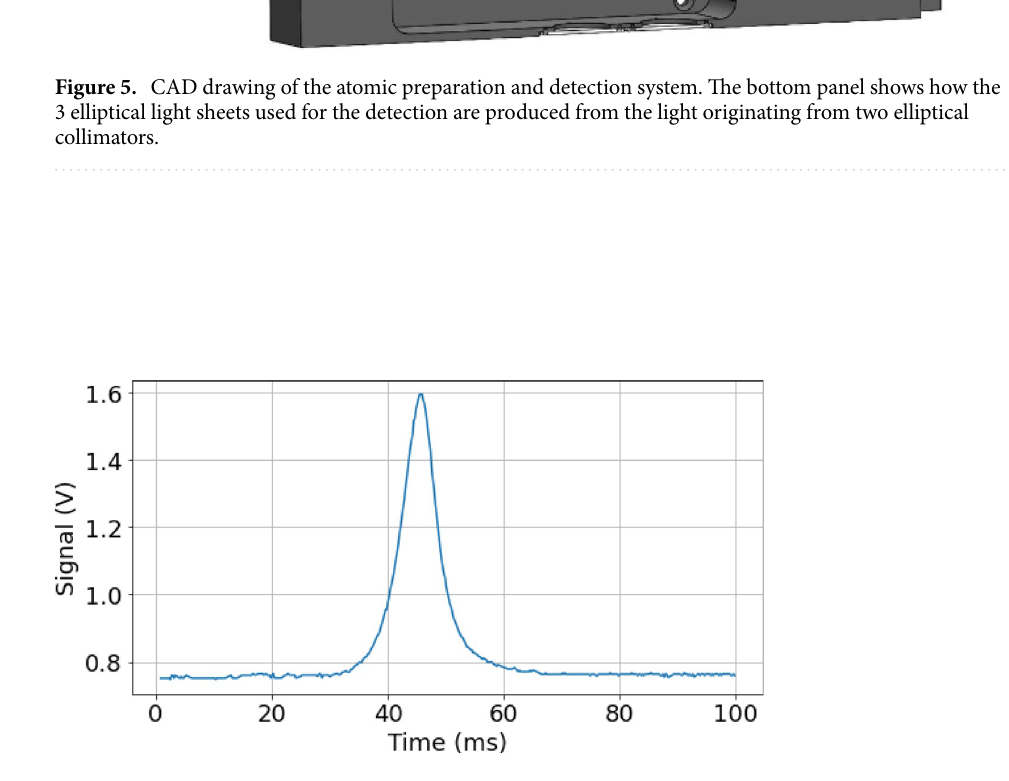
Figure 6. Time of flight fluorescence signal of the upper light sheet (atoms in F